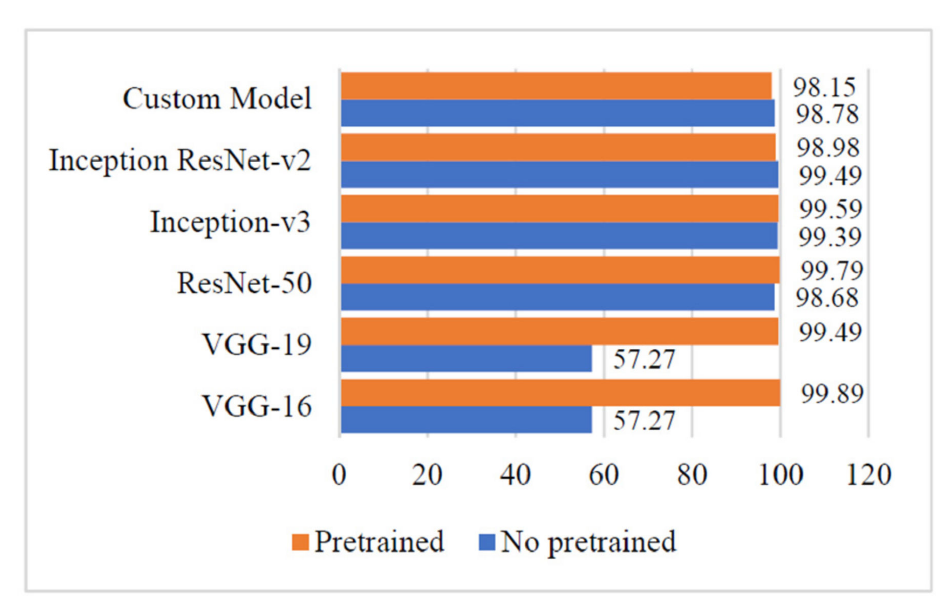
Figure 7. Average accuracy of different deep learning